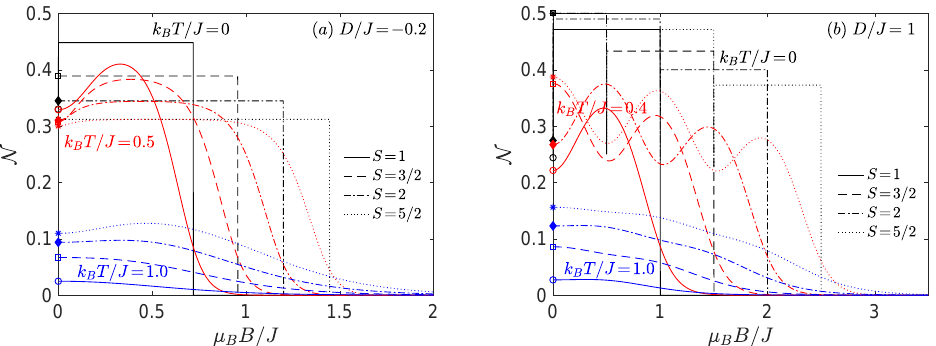
Figure 6. The negativity as a function of the external magnetic field for four different spin magnitudes, three different values of temperature and two selected values of the uniaxial single-ion anisotropy: ( a ) D / J = − 0.2; ( b ) D / J = 1.